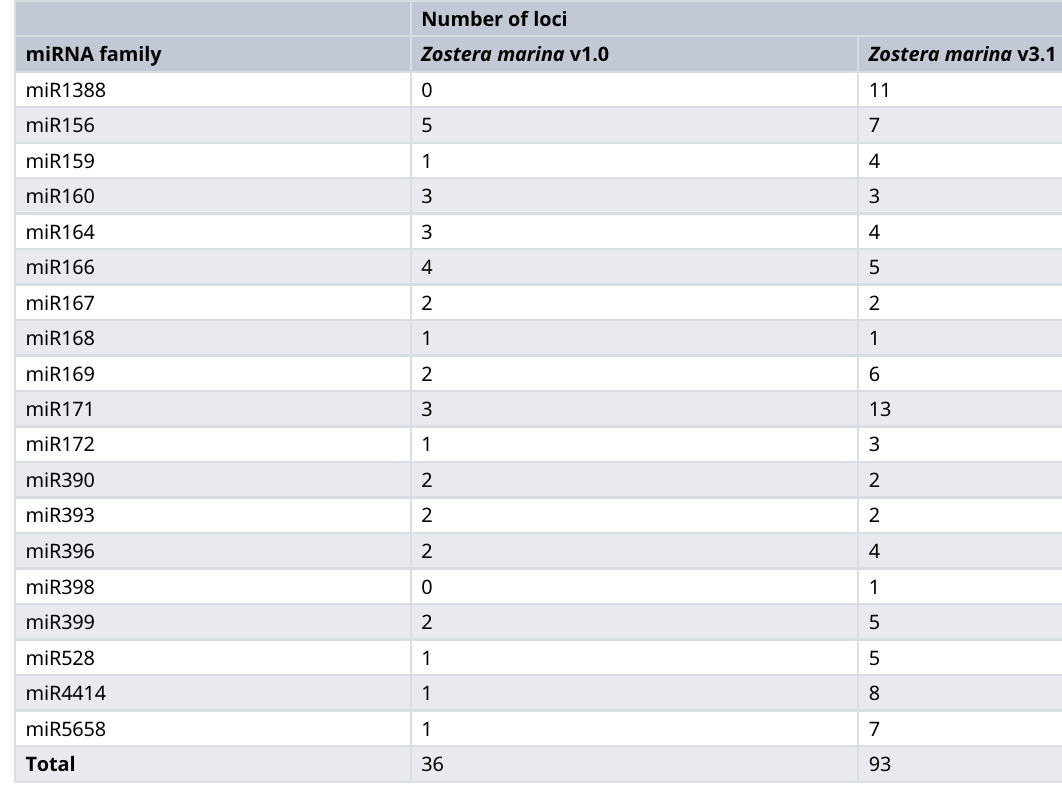
Table 3. Known miRNAs identified in the genome of Zostera marina (v1.0 and v3.1).